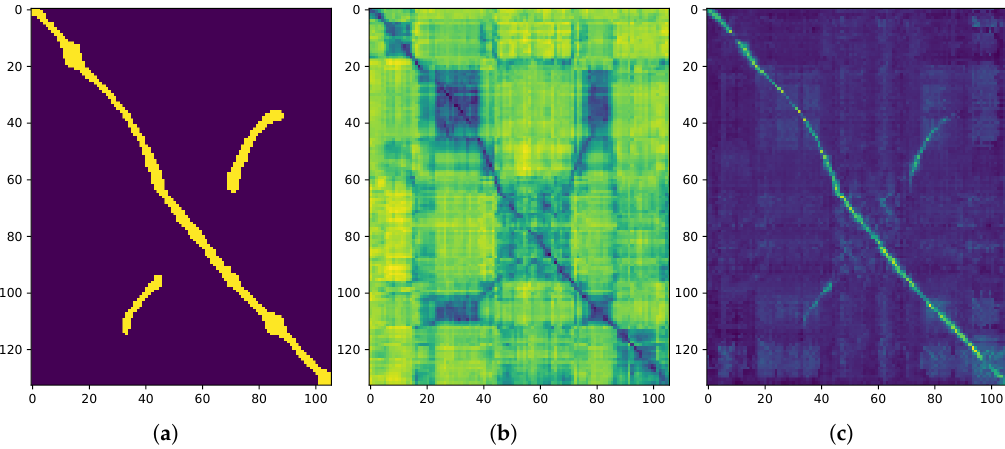
Figure 8. Graphical representation of the SE ( 2 ) distance with 25m threshold applied (c.f. Section 5.2) to form a binary mask used as ground-truth ( a ), embedding distance ( b ) and quality score ( c ) for each pair of radar scans in two separate trials. For each matrix visualised here, the vertical and horizontal axes are in units measuring the number of frames in the query and reference trajectories, respectively. Note that in ( b ) frames which are proximal in embedding space are shaded dark, while the inverse is true for ( c ), where frames with high quality-scores are shaded lightly. It is especially important to note that the quality-score matrix in ( c ) is not computed in its entirety during online operation (prohibitively computationally expensive) but is shown in full here for illustrative